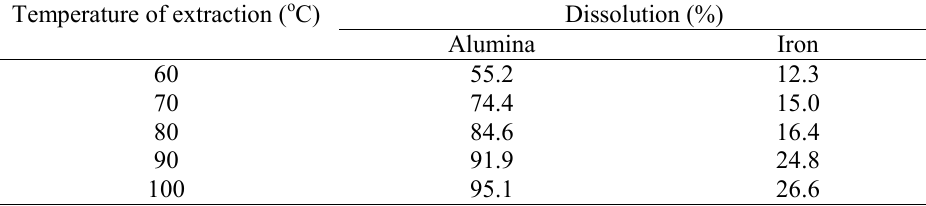
Table 6. Effect of temperature on the extraction of alumina and iron from clays calcined at 750 o C for 30 min, and leached with 3M sulfuric for 120 min at an acid to clay ratio is 80